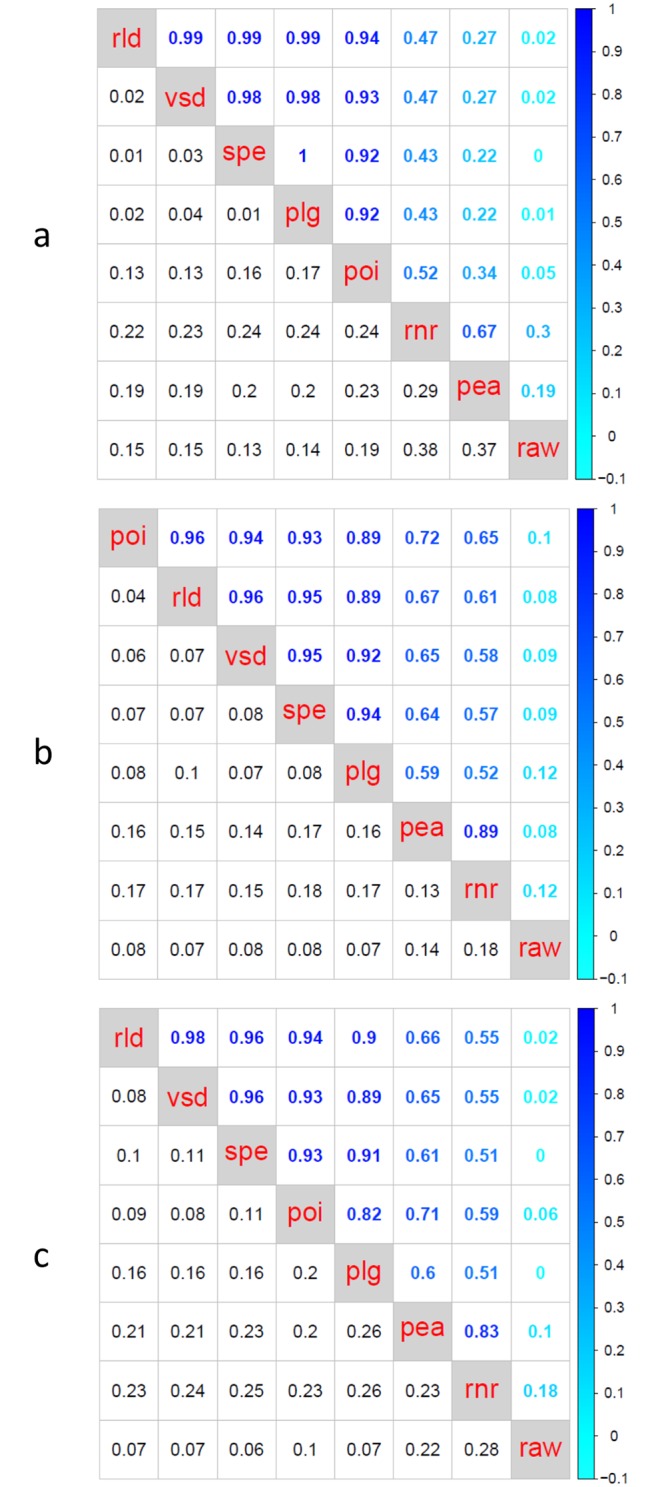
Agreement between dissimilarity measures using Bottomly plasmode datasets.Each matrix contains means (upper triangle) and standard deviations (lower triangle) of correlation between cophenetic matrices of dendrograms (N = 50 plasmode datasets) for eight dissimilarity measures: Euclidean distances using raw count data (raw), Euclidean distances using normalized samples (rnr), Euclidean distances using variance stabilizing transformation (vsd), Euclidean distances using regularized logarithm (rld).) 1- Pearson correlation using raw counts (pea), 1- Pearson correlation using counts transformed by logarithm of raw counts +1 (plg), and 1- Spearman correlation using raw counts (spe), and Poisson dissimilarity (poi). Panel labels (a), (b) and (c) correspond to one of three scenarios of proportion of differential expressed genes: DE[100%], DE[10%]+nonDE[90%], and DE[20%]+nonDE[80%], respectively. In all scenarios, we identified three sets of dissimilarity measures: 1) raw, 2) rnr and pea, and 3) poi, rld, vsd, plg and spe. Results from raw, set 1, were poorly related to results from any other dissimilarity measure. Dendrograms from dissimilarity measures in set 2 presented correlation of cophenetic matrices with medium to high means and high variability with each other, and low correlation with dendrograms from other dissimilarity measures. Dendrograms from dissimilarity measures in set 3 exhibited high correlations of cophenetic matrices and low to medium variability when compared to each other.